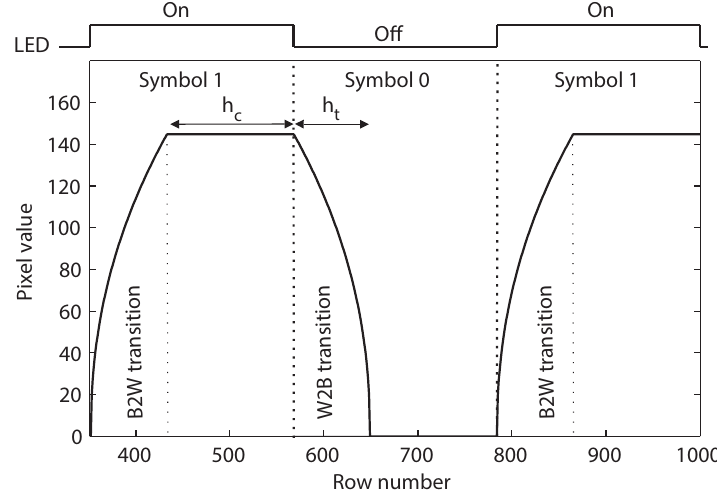
Figure 6. The intersymbol interference (ISI) caused by the transition